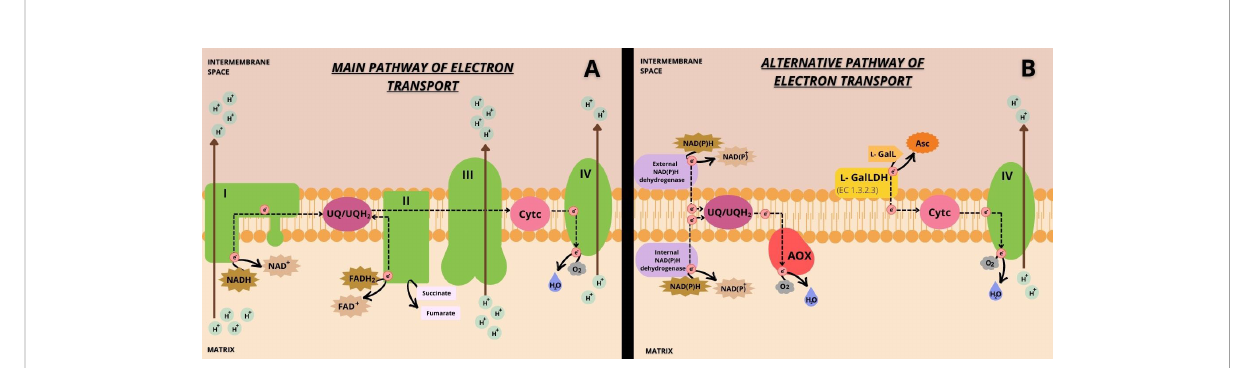
FIGURE 4 Illustrative scheme of the main (A) and alternative (B) pathways of Cytc reduction with the transport of electrons and proton pumping in mETC. In the main pathway (A) , electrons enter the mETC through Complexes I and II and may be used for UQ reduction. This is commonly referred to as the main pathway of UQ reduction by Complexes I and II. Then, UQH 2 can reduce Cytc, passing electrons through Complex III. Cytc is re- oxidized transferring electrons to Complex IV, which can reduce molecular oxygen. In the alternative pathway (B) , electrons enter the mETC through alternative NAD(P)H dehydrogenase [NAD(P)H DH] and through L -GalLDH. Electrons entering through alternative NAD(P)H DH are mostly transferred to AOX via UQ/UQH 2 , reducing molecular oxygen. This is called the alternative pathway of UQ reduction by alternative NAD (P)H dehydrogenases. Electrons entering through L -GalLDH are not engaged with UQ/UQH 2 and are directly transferred to Cytc, and this is thus called the alternative pathway of Cytc reduction by L -GalLDH. Finally, Cytc would be re-oxidized by Complex IV coupled with reduction of the molecular oxygen. The black dotted arrows indicate the electron transport pathways within the mETC. The brown arrows represent the site of proton transport that occurs from the matrix to the mitochondrial intermembrane space. The transmembrane location of the L -GalLDH enzyme is indicated by the yellow folded shape, and the enzyme activity shows the association of the enzyme with electron fl ow in the mETC. In green are the four mETC Complexes indicated by the corresponding Roman numerals, I-IV. AOX is represented in red and the internal and external NADP(H) dehydrogenases in purple. The ubiquinone pool and cytochrome c are represented in magenta and pink,